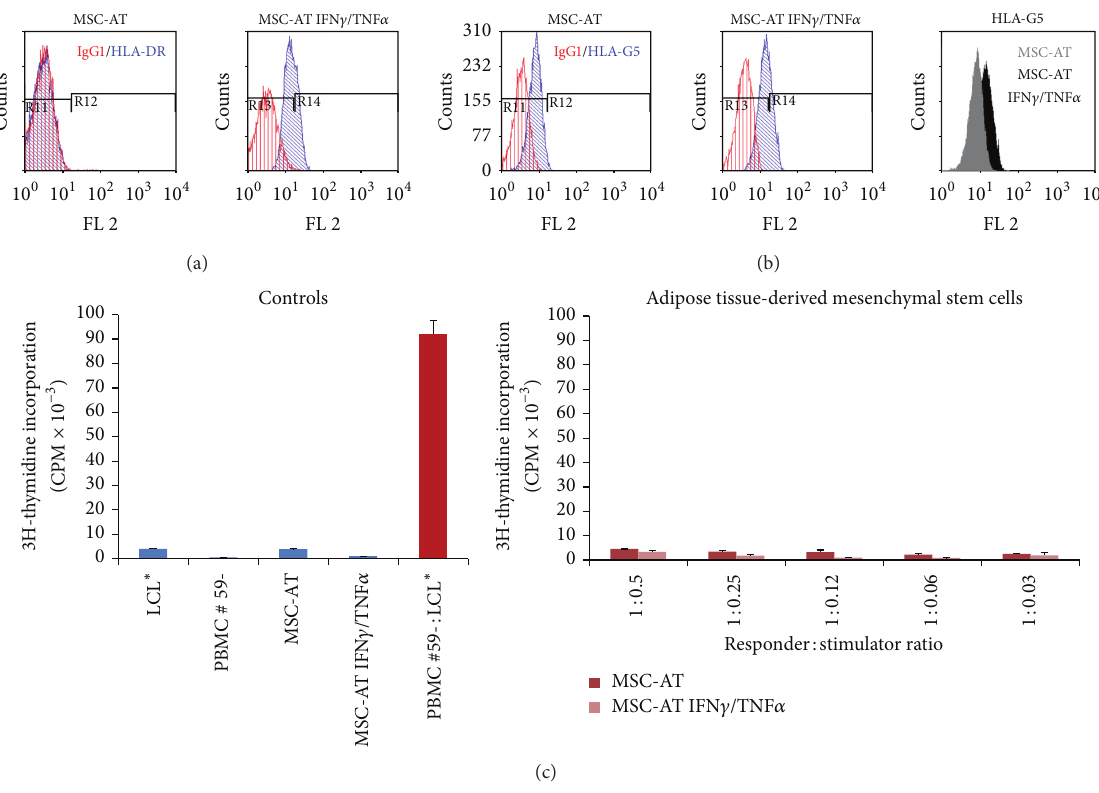
Figure 2: AT-derived MSCs express HLA-G and are hypoimmunogenic. (a) Expression of HLA-DR molecules was evaluated by flow cytometry analysis on AT-derived MSCs pretreated with IFN 𝛾 and TNF 𝛼 (MSC-AT IFN 𝛾 /TNF 𝛼 ) or not (MSC-AT). IgG1 was used as isotype control Ab. (b) Expression of HLA-G5 was evaluated by intracellular flow cytometry analysis on AT-derived MSCs pretreated with IFN 𝛾 and TNF 𝛼 (MSC-AT IFN 𝛾 /TNF 𝛼 ) or not (MSC-AT). (c) PBMC from healthy individual (#59-) were used as responder cells towards AT-derived MSCs pretreated with IFN 𝛾 and TNF 𝛼 (MSC-AT IFN 𝛾 /TNF 𝛼 ) or not (MSC-AT) as stimulating cells at various responder:stimulator ratios. Irradiated LCL ∗ were used as positive control of T cell alloproliferation. Results are given as mean cpm ± s.e.m.; one representative experiment is